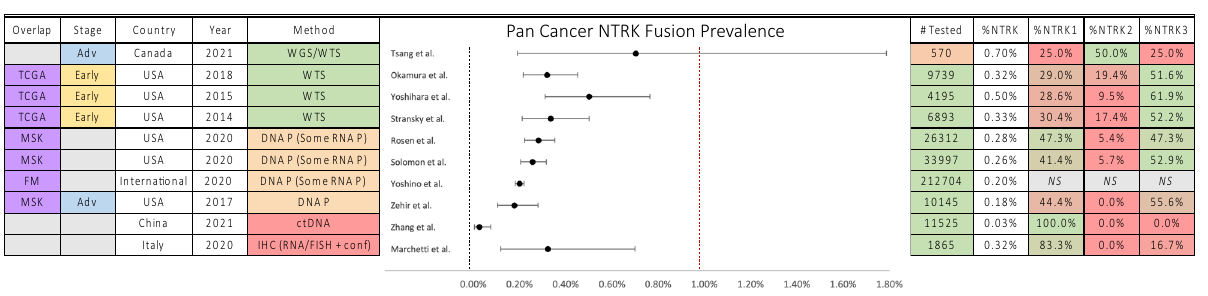
Figure 3. Summary of prevalence of NTRK fusions in pan-cancer studies (adult and combined). TCGA The Cancer Genome Atlas, MSK Memorial Sloan Kettering, FM Foundation Medicine, Adv Advanced or Metastatic,